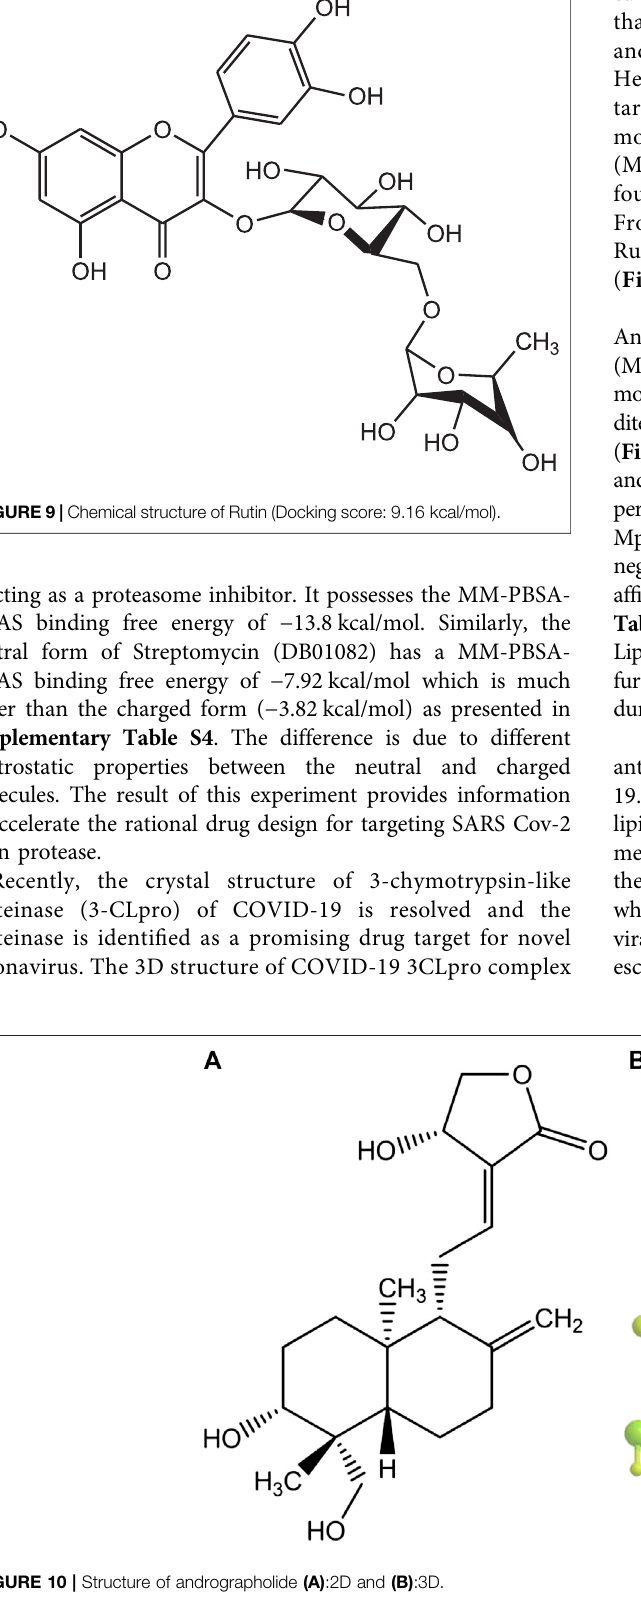
FIGURE 10 | Structure of andrographolide (A) :2D and (B)